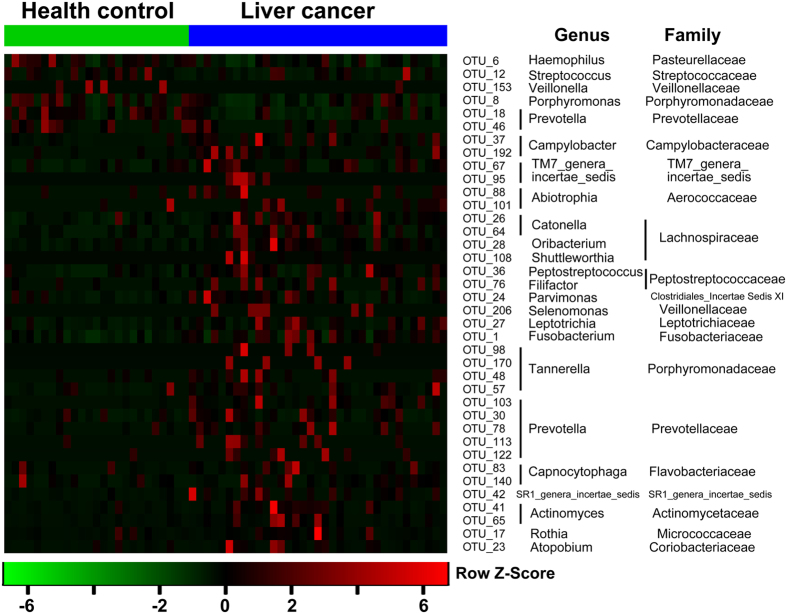
Heat maps of the relative abundances of the discriminatory OTUs that drive the differences between LCT and HT.For each sample, the columns show the relative abundance data of the discriminatory OTUs listed to the right of the figure. The abundances of the genera were clustered using unsupervised hierarchical clustering (blue, low abundance; red, high abundance). The family and genus of each key OTU is noted to the right of the figure. LCT, liver cancer patients tongue coat; HT, healthy subjects tongue coat.